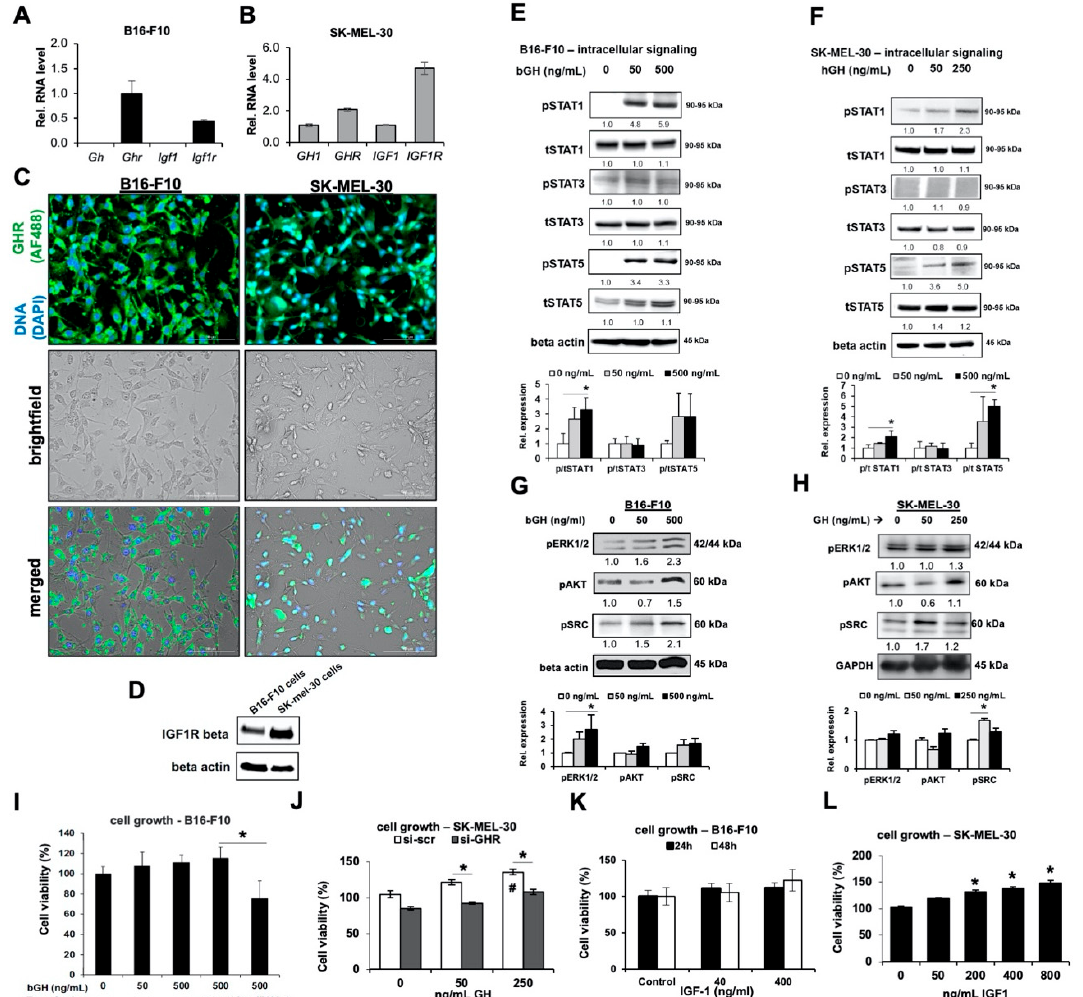
Figure 1. Melanoma cells are responsive to GH treatment in vitro. ( A ) Relative RNA expression was quantified for Gh , Ghr , Igf1 and Igf1r genes in B16-F10 mouse melanoma cells (n = 3). ( B ) Relative RNA expression was quantified for GH , GHR , IGF1 and IGF1R genes in SK-MEL-30 human melanoma cells, normalized against GAPDH (n = 3). ( C ) B16-F10 and SK-MEL-30 cells were stained with GHR antibody. Top panels present cellular DNA stained with DAPI (blue) and fluorescent signals from AF488-tagged anti-GHR antibody (green). Middle panels represent brightfield views while bottom panels represent merged views (20 × magnification; scale bar represents 100 µ m). ( D ) Expression of IGF1R-beta was detected in B16-F10 and SK-MEL-30 cells via western blotting. ( E ) Representative images of western blot analyses of phosphorylation (p) and total (t) levels of STATs 1, 3 and 5 in bovine GH (bGH) treated B16-F10 melanoma cell lysates. Cells were treated for 30 min and lysed. Densitometry analysis was performed and normalized against β -actin. The fold changes relative to control are labeled under each band. The ratio of p / t protein levels are quantified against controls and shown in bar graphs (n = 3). ( F ) Similar results for SK-MEL-30 cells treated with human (h) GH for 30 min were obtained. ( G , H ) Changes in GH signaling proteins, pERK1 / 2, pAKT and pSRC, in B16-F10 cells and SK-MEL-30 cells treated with bGH or hGH for 48 h. Protein levels were normalized against β -actin or GAPDH. ( I ) Changes in cell proliferation of B16-F10 cells transfected with scramble or GHR-targeted siRNA (siRNA-2), after 48-h treatment with bGH. ( J ) Similar results were observed in SK-MEL-30 cells transfected with scramble (si-scr) or GHR-targeted siRNA (si-GHR), after 48-h treatment with hGH (* as compared with si-scr group, # as compared with no treatment group). ( K ) Changes in cell proliferation of B16-F10 cells treated with increasing doses of IGF-1 for 24 and 48 h. ( L ) Changes in cell proliferation of SK-MEL-30 after 48-h treatment with recombinant human IGF-1 (n = 5). Data are presented as mean ± standard deviation (*, p < 0.05, Mann-Whitney U test).